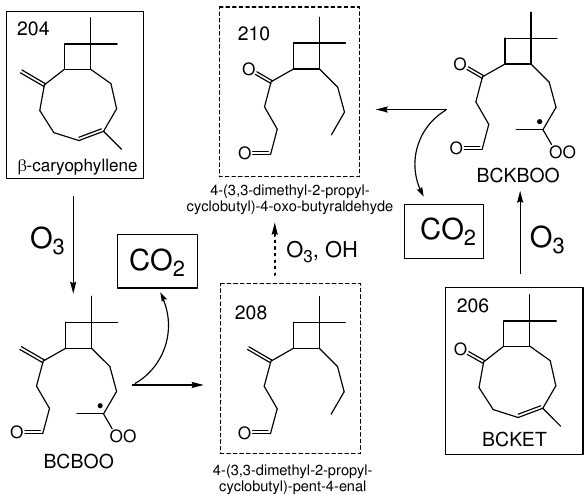
Fig. 16. Formation routes for additional products not in MCM Figure 16. Formation routes for additional products not in MCM v3.2 that potentially 3 v3.2 that potentially contribute to CIR-TOF-MS signals at m / z 209 contribute to CIR-TOF-MS signals at m/z 209 and m/z 211. 4-(3,3-dimethyl-2-propyl-4 and m / z 211. 4-(3,3-dimethyl-2-propyl-cyclobutyl)-pent-4-enal has cyclobutyl)-pent-4-enal has been reported as a first-generation ozonolysis product by 5 been reported as a first-generation ozonolysis product by Kanawati Kanawati et al. (2008) (denoted 208-E-C1), and Winterhalter et al. (2009) (denoted P3). 6 et al. (2008) (denoted 208-E-C1), and Winterhalter et al. (2009) (de- noted